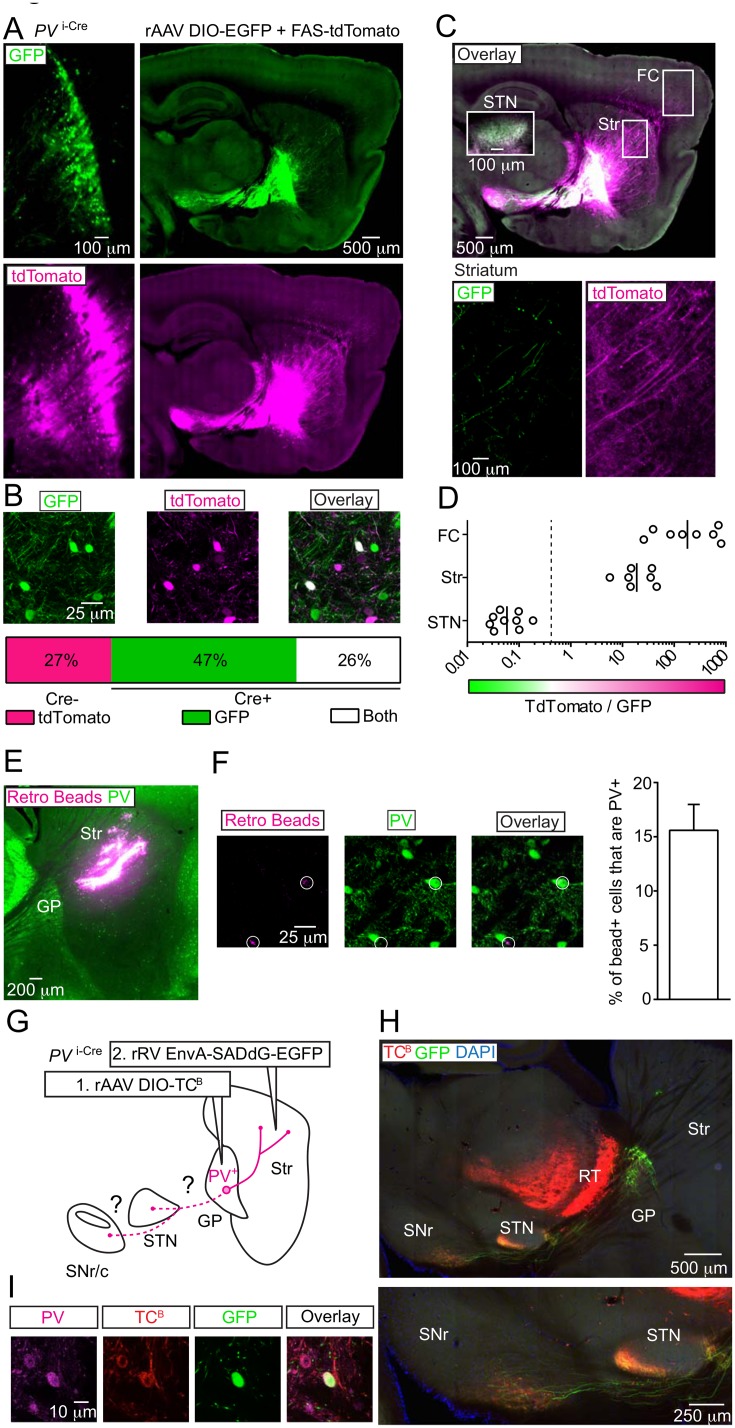
PV+ GP neurons innervate the striatum in addition to the STN and SNr.(A) Sagittal brain section from a PV
i-Cre mouse injected in the GP with rAAVs DIO-EGFP (Cre-On, green) and FAS-tdTomato (Cre-Off, magenta). Left, injection site in GP. Right, low-magnification view. Look up table was changed to illustrate axonal projection patterns in low-magnification view. (B) Quantification of co-localization between GFP (green) and tdTomato (magenta) expressing GP neurons from confocal microscopy. Top, a single confocal plane. Bottom, summary graph of co-localization. All GFP expressing neurons are Cre+ (n = 76/285 cells tdTomato+ only; n = 134/285 cells GFP+ only; n = 75/385 cells double-positive, from n = 3 injections, from 2 mice). (C) Overlay of low-magnification sagittal sections from (A). Top, boxes indicate approximate regions of the frontal cortex (FC), striatum (Str) or subthalamic nucleus (STN, from an adjacent section) where GFP and/or tdTomato axonal fluorescence was quantified. Bottom, high magnification view of the striatum. (D) Relative expression of Cre+ and Cre- axons in the FC, Str and STN following pixel binarization of GFP+ and tdTomato+ fluorescence. Since all GFP+ axons are Cre+, the relative abundance of Cre-/Cre+ fibers is plotted as (tdTomato-GFP)/GFP pixels. The dotted line shows the relative proportion of Cre-/Cre+ axons predicted for no selective innervation of different brain areas based on somatic co-localization quantified from the injection site (tdTomato only cells / (GFP only + tdTomato and GFP double-positive cells), from data in (B): 76/(134+76) = 0.364). Solid lines represent geometric means (n = 3 injections, from 2 mice). Innervation ratios were different across regions (P < 0.05, Kruskall-Wallis test). (E) Retrograde labeling of PV- and PV+ GP somata. Sagittal section of wild-type mouse following injection of retro beads (magenta) in dorsal striatum and immunolabeling of PV (green). (F) Quantification of co-localization between retro bead+ (magenta) and PV+ (green) cells in the GP using confocal microscopy. Left, a single confocal plane. Bead+ cells are highlighted with circles. Right, summary graph of mean co-localization (from 4 mice). Error bars denote s.e.m. (G-I) Full anatomical visualization of PV+ GP-Str neurons following rabies-based retrograde labeling in PV
i-Cre mice. (G) Experimental strategy to test whether PV+ GP-Str neurons also innervate the STN and SNr. First, rAAV DIO-TCB is injected into the GP of PV
i-Cre, allowing TCB+ axons to be selectively transduced by EnvA pseudo-typed recombinant rabies virus (rRV). Second, replication-incompetent rRV EnvA-SADdG-EGFP is injected into the striatum 2 weeks after the rAAV injection. GFP+ axons in the STN and SNr indicate innervation by PV+ GP-Str neurons. (H) Top, low magnification sagittal section from an example double-recombinant viral experiment described above. TCB+ expression is restricted to Cre+ neurons of the GP and reticular nucleus of the thalamus (RT). The vast majority of GFP+ somata were observed in the GP. Additionally, a sparse number of GFP+ somata with glial morphology or aspiny dendrites were also present in the striatum. GFP+ axons were clearly visible in the striatum, as well as the STN and SNr. Below, higher magnification view of the STN and SNr from the section above. Similar labeling was observed in n = 6/6 injections from 3 mice and n = 0/4 control injections from 2 mice in which DIO-TCB was replaced by DIO-mCherry. (I) A single confocal plane of the GP from the experiment shown, demonstrating that TCB+/GFP+ GP neurons are also immuno-positive for PV.